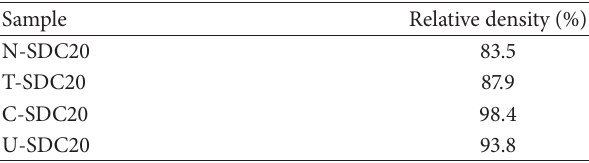
Table 3: Relative density of the sintered pellets. Sample Relative density